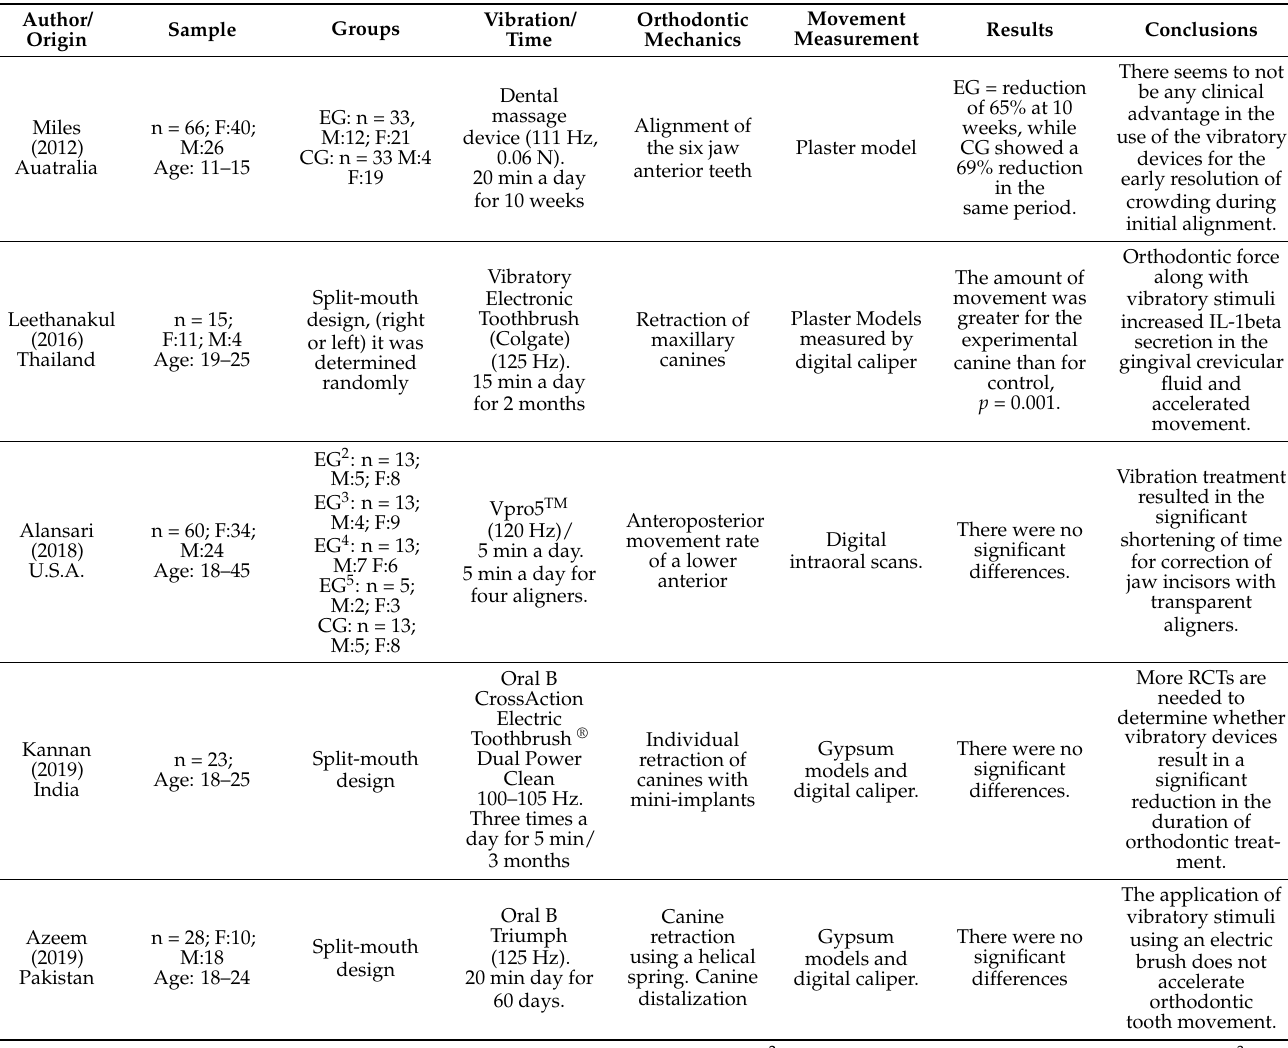
Table 2. Summary of characteristics of the high-frequency vibration